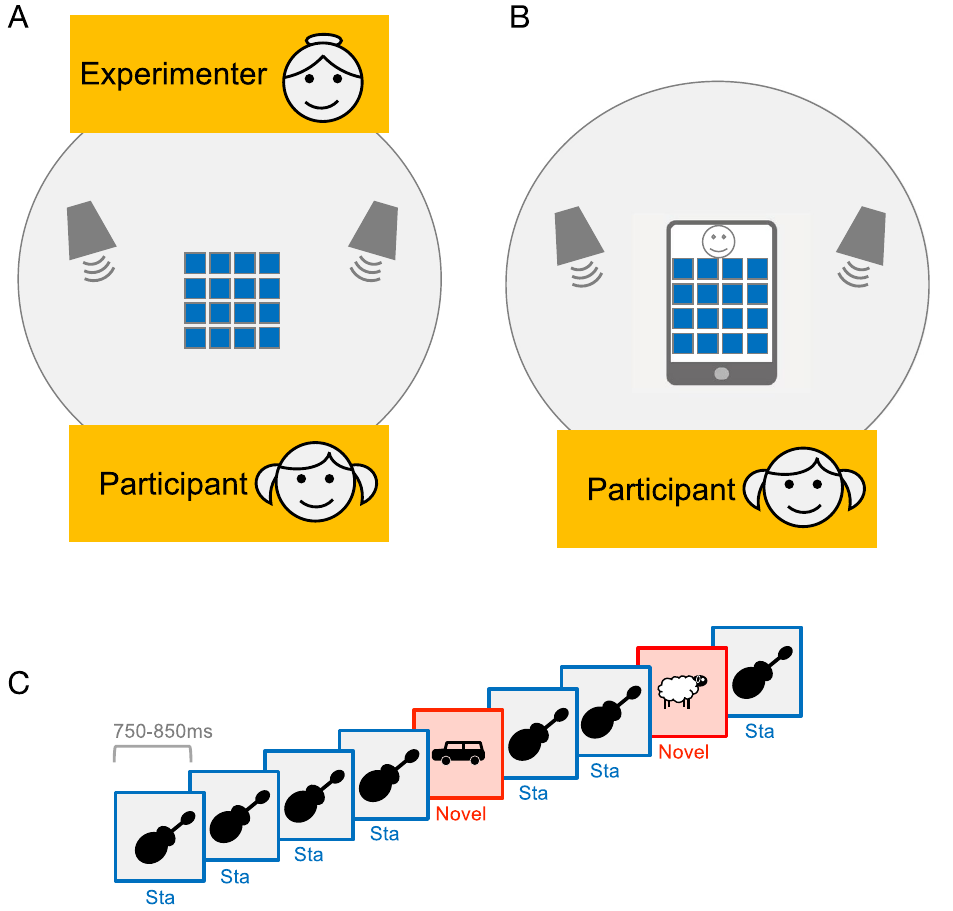
Figure 1. Setting and oddball paradigm. Children sat at a table and played the game Memory alternately with an experimenter sitting face to face ( A ) or with a Memory game App on a Tablet PC ( B ). In both conditions, a sound sequence consisting of repetitive standard sounds (sound of guitar) and rarely and randomly interspersed new environmental sounds was presented during the game ( C ). Children were instructed to ignore the sounds. The figure was created using Microsoft Powerpoint (version 16.52, https:// www. micro soft. com/ de- de/ micro soft- 365/ micro soft-